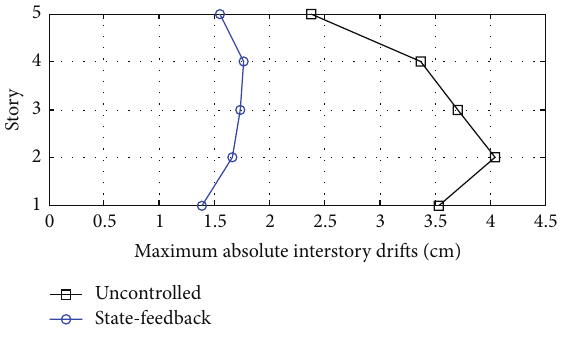
Figure 3: Maximum absolute interstory drifts corresponding to the uncontrolledbuilding(blacklinewithrectangles)andthecontrolled building with the ideal state-feedback energy-to-peak controller ̃𝐺 defined by the gain matrix 𝑠 (blue line with circles). The full scale North-South El Centro 1940 seismic record has been used as ground acceleration disturbance.